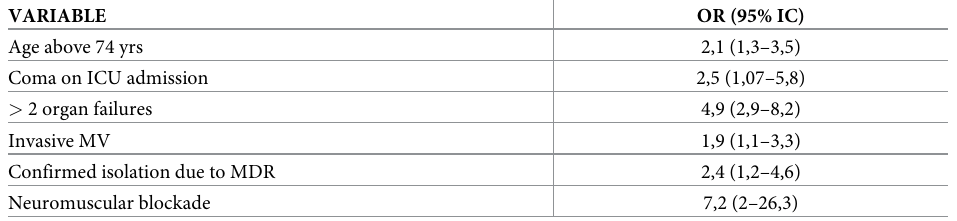
Table 3. Multivariate